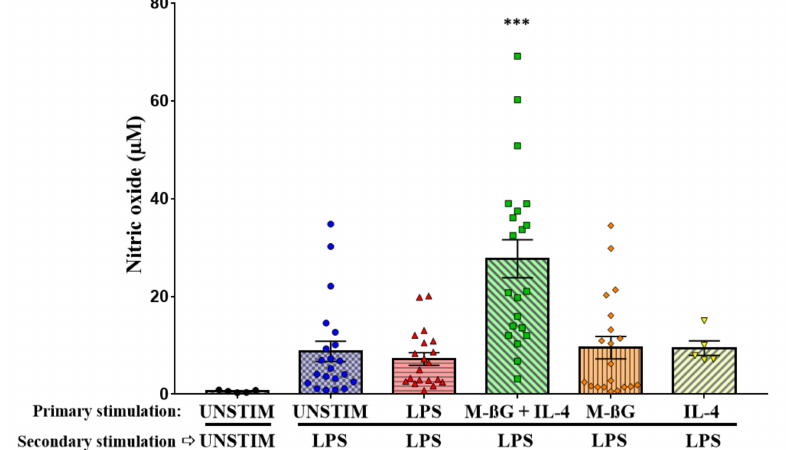
Figure 4. Primary stimulation with β -glucan microparticulates + IL-4 enhanced the NO production after secondary stimulation of LPS. Freshly isolated adherent cells were primary stimulated with culture medium (UNSTIM), LPS (10 µ g / mL), M- β G (10 µ g / mL), M- β G + IL-4 (10 µ g / mL + 100 ng / mL) or IL-4 (100 ng / mL) on D0. The cells were secondary stimulated with LPS (10 µ g / mL), except for the negative control (UNSTIM-UNSTIM) on D6. NO production after the secondary stimulations are shown in this figure. Only cells primary stimulated with the combination M- β G + IL-4 showed increased NO production after a secondary stimulation with LPS compared to primary unstimulated cells ( N = 21 chickens). Each bar represents mean ± SEM. *** p <